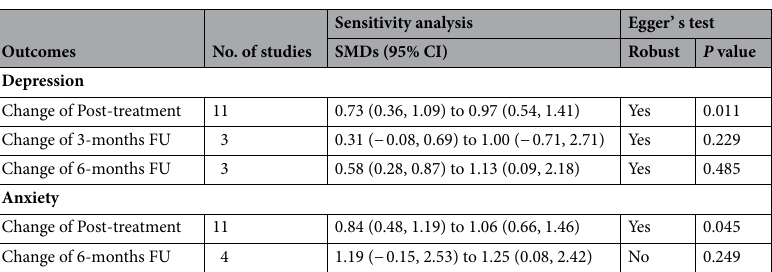
Table 3. Outcomes of the sensitivity analysis and test of publication bias. FU,